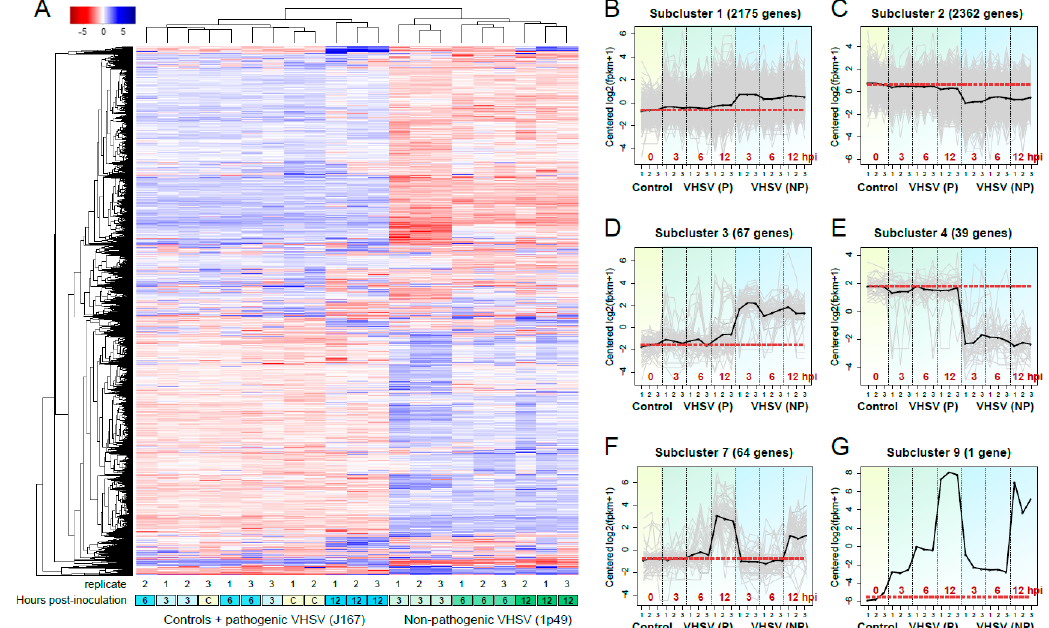
Figure 2. ( A ) Heatmap showing clustering of all differentially expressed genes in the rainbow trout gonad cell line RTG-2 inoculated with either the non-pathogenic (NP) 1p49 or the pathogenic (P) J167 viral haemorrhagic septicaemia virus (VHSV) isolates at 3, 6, and 12 h post-inoculation. ( B – G ) Partitioning of differentially expressed genes into gene clusters with similar expression profiles over time.